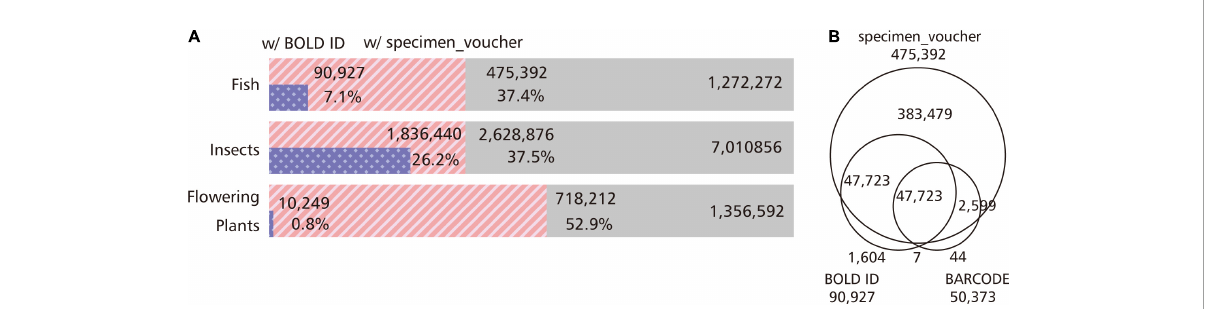
FIGURE1 Status of entries with information related to the DNA barcoding in GenBank. By using GenBank, we extracted the BARCODE from the KEYWORD section, the BOLD ID referenced as the ID of the external database in the db_xref qualifier, and the sample ID written in the specimen_voucher qualifier as information related to DNA barcoding. (A) Percentage of entries with BOLD ID and the specimen_voucher qualifier. We examined the proportion of entries with BOLD ID and the specimen_voucher information in fish, insects, and flowering plants. In insects, a quarter of the entries correspond to barcode sequences with links to BOLD, and rich barcode information can be obtained from GenBank. Plants, on the other hand, have poor links to BOLD, but half of the entries are assigned specimen IDs, and DNA barcode candidates may be hidden in these entries. (B) Venn diagram of entries with BARCODE keyword, BOLD ID, and specimen_voucher qualifier. We examined the overlap of entries with the BARCODE keyword, BOLD ID, and sample ID in the GenBank fish data. In order to extract the entry corresponding to the DNA barcode, not only the BARCODE in the KEYWORD section must be extracted, but also the entry with the BOLD ID as the external database